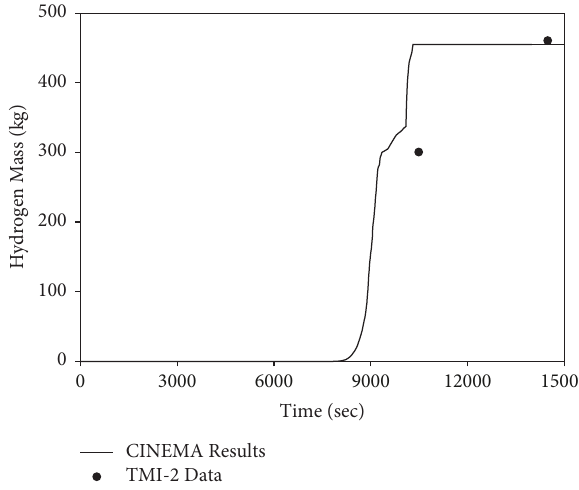
Figure 12: Comparison of CINEMA results with TMI-2 data on the generated hydrogen